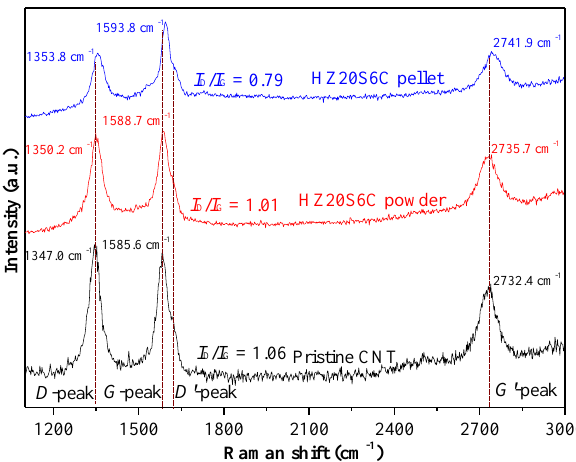
Figure 4. Raman spectra showing D , G , D’ , and G’ peak of CNT in CNT reinforced composite powder as well as a pellet.